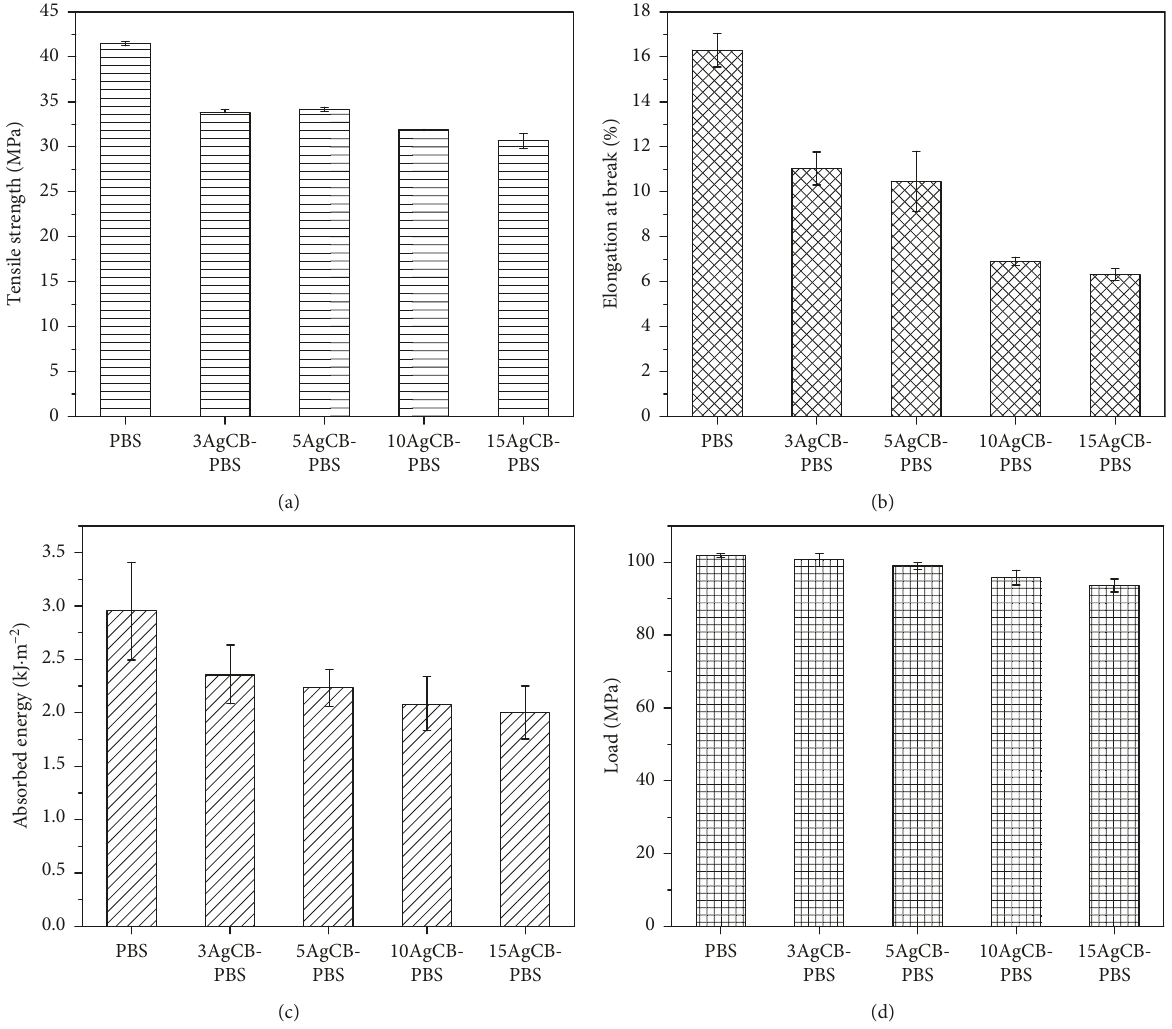
Figure 11: (a) Tensile strength, (b) elongation at break, (c) impact strength, and (d) bending strength of the pristine PBS as well as the x AgCB-PBS composite